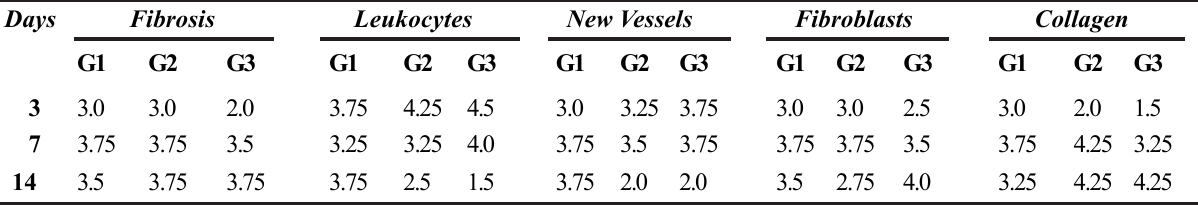
TABLE 1 - Representation of the means obtained through semiquantitative analysis of the thin sections relating to the three groups: malnourished and untreated (G1), malnourished and treated (G2) and normal nutrition and treated